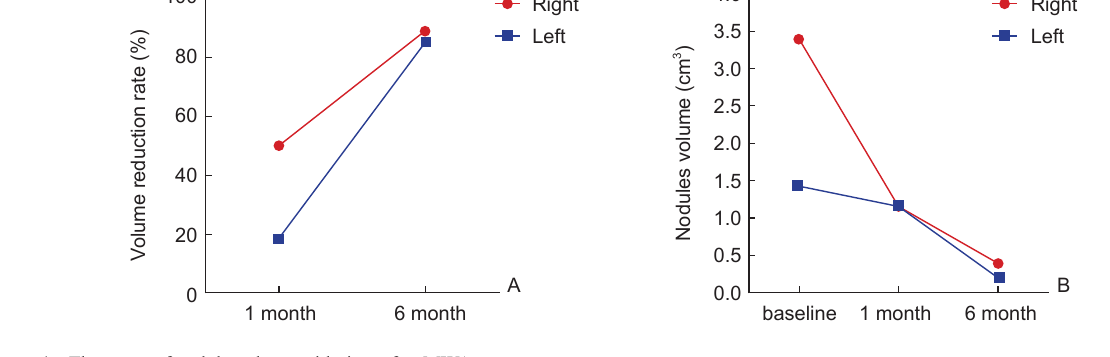
Figure 4 The curve of nodule volume with time after